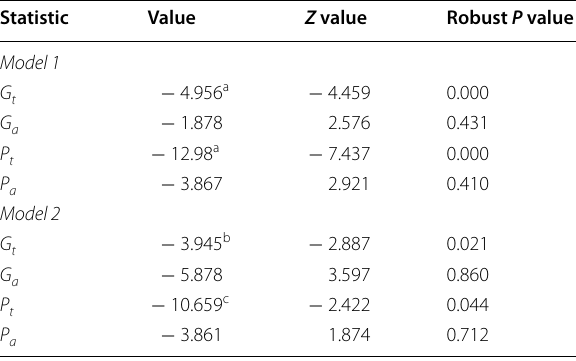
Table 4 Cross-sectional dependence results